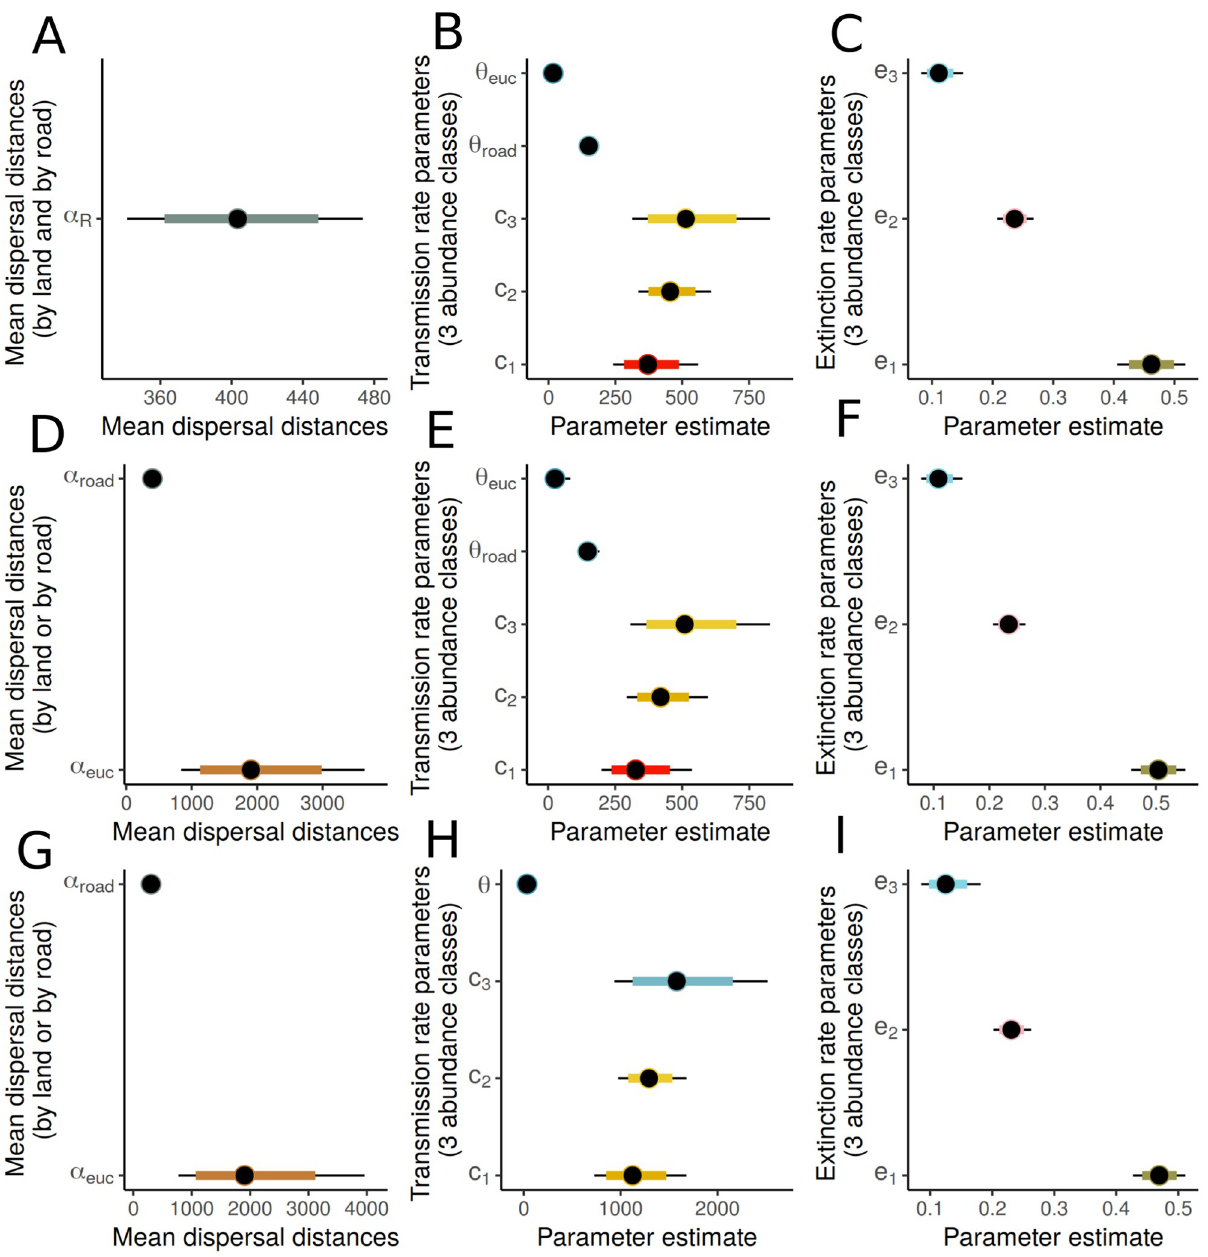
Fig 5. The parameter estimates (medians and 80% and 95% credibility intervals) for the fitted mechanistic within-season transmission models. Panels A, B and C correspond to mechanistic model 1, panels D, E and F correspond to mechanistic model 2 and panels G, H and I correspond to mechanistic model 3. As an example, panel A depicts the estimated mean dispersal distances by land ( α the estimated colonization rates from patches with different abundance of infection ( c 1 being the smallest abundance class), and the estimated pathogen population extinction rates for the pathogen populations with different abundances of infection. The axis limits are different in each